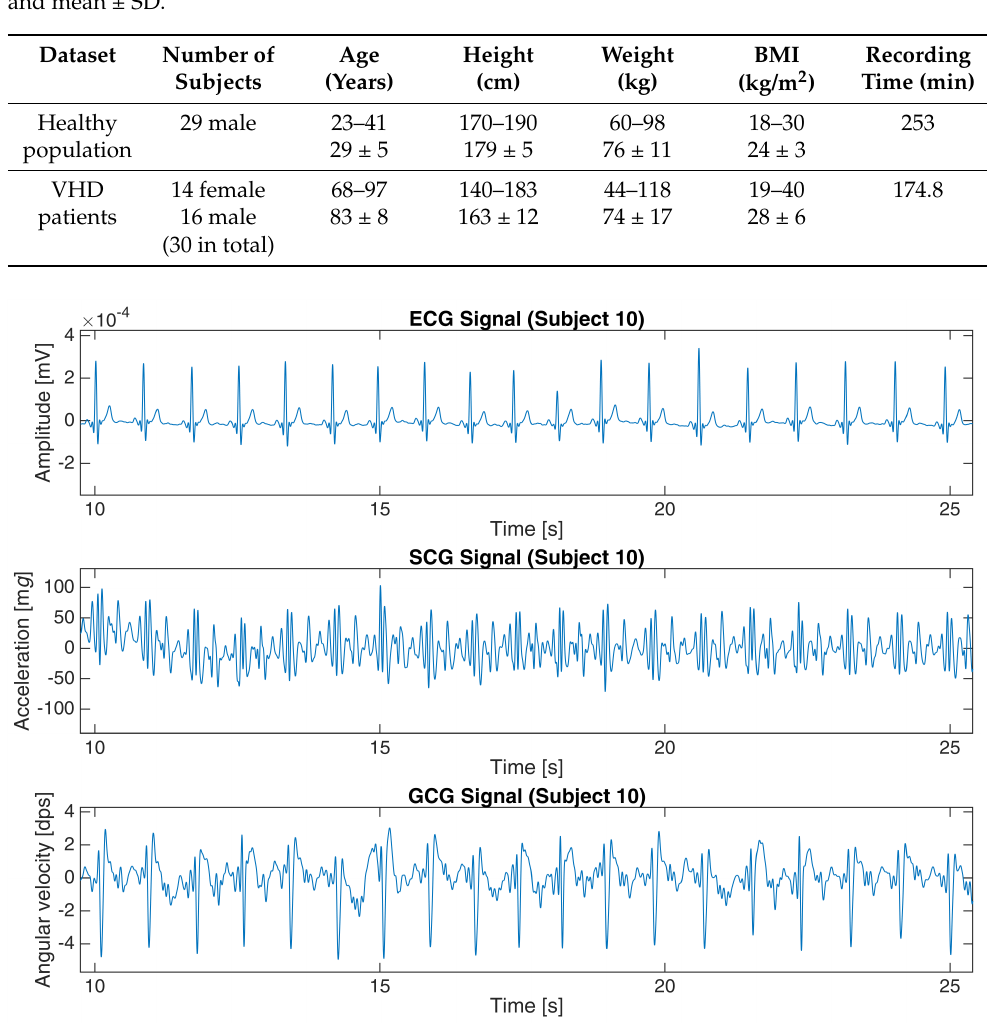
Figure 2. ECG, SCG and GCG signals from subject 10 in the first dataset (25-s